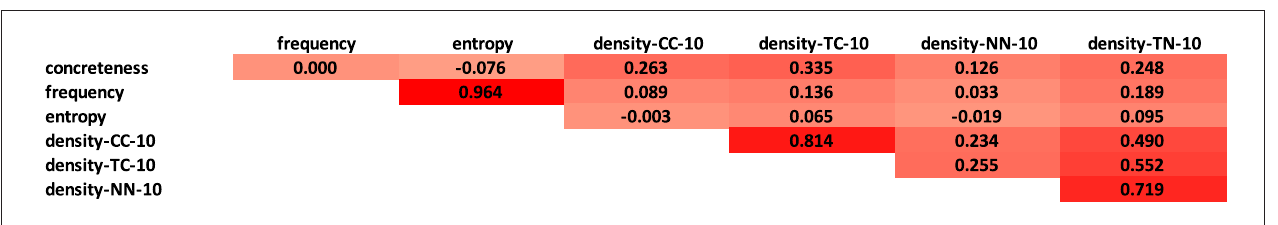
FIGURE 12 | Spearman’s ρ correlations between noun concreteness measures (N-V-A space).